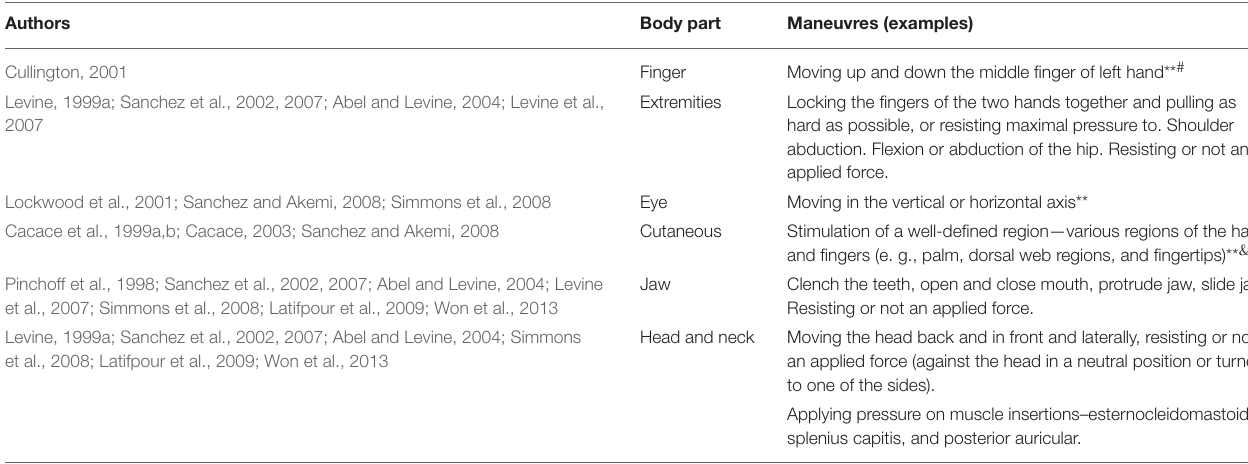
TABLE 1 | Summary of somatic